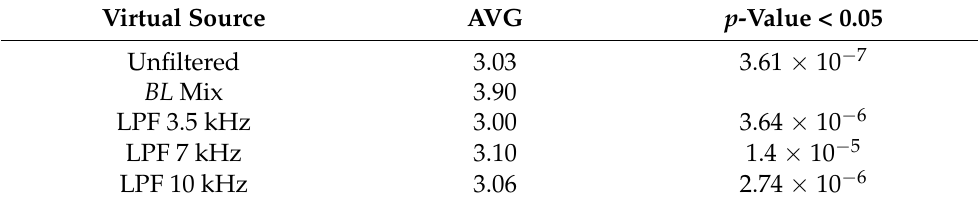
Table 6. T -test results—general AVG.